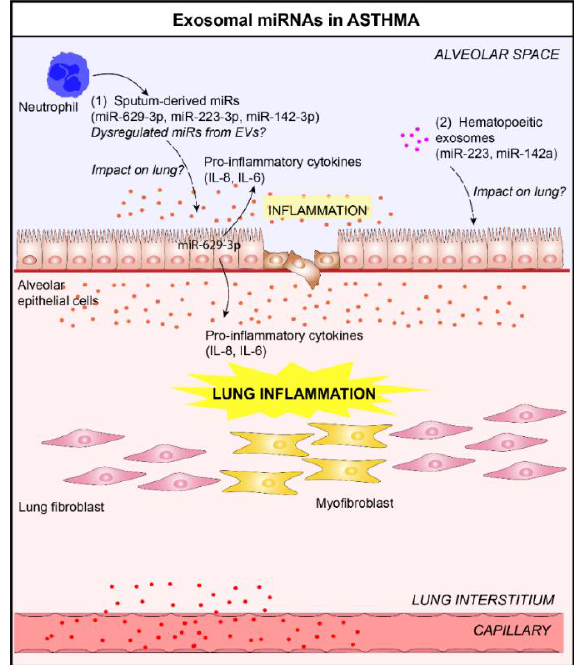
Figure 3. Role of lung EVs in the pathogenesis of asthma. ( 1 ) In the context of asthma, elevated levels of three sputum microRNAs (miRNAs), miR-629-3p, miR-223-3p, and miR-142-3p, in the sputum of patients with severe asthma, have been reported [47]. The delivery of miR-629-3p in lung ECs could participate in lung inflammation (release of pro-inflammatory cytokines, interleukin (IL)-6 and IL-8, by ECs) [47]. ( 2 ) The levels of EV-derived miRNAs selectively expressed by immune cells, including miR-223 and miR-142a, increased in bronchoalveolar lavage fluid (BALF) from allergen-treated